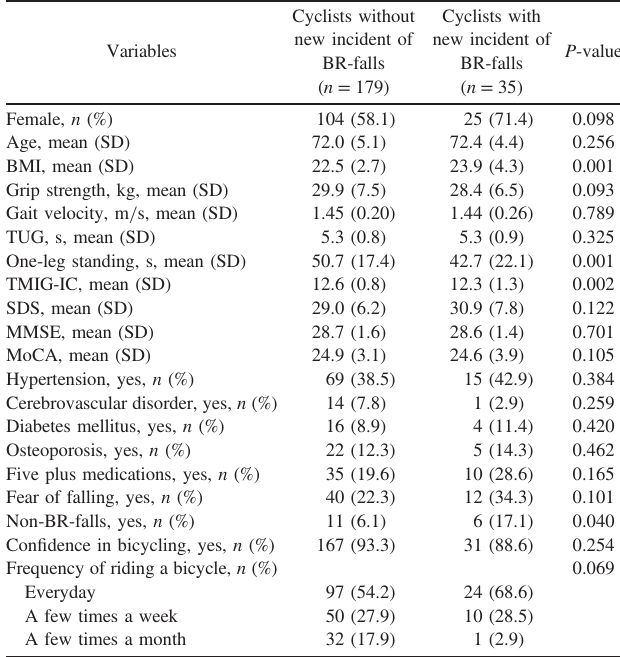
Table 3. Baseline characteristics and di ff erences of measure- ments of the cyclists with newly incident of bicycle- related falls (BR-falls) and those who never reported BR-falls at the follow-up assessment Cyclists without Cyclists with P -value BR-falls BR-falls ( n = 350) ( n = 45) Variables